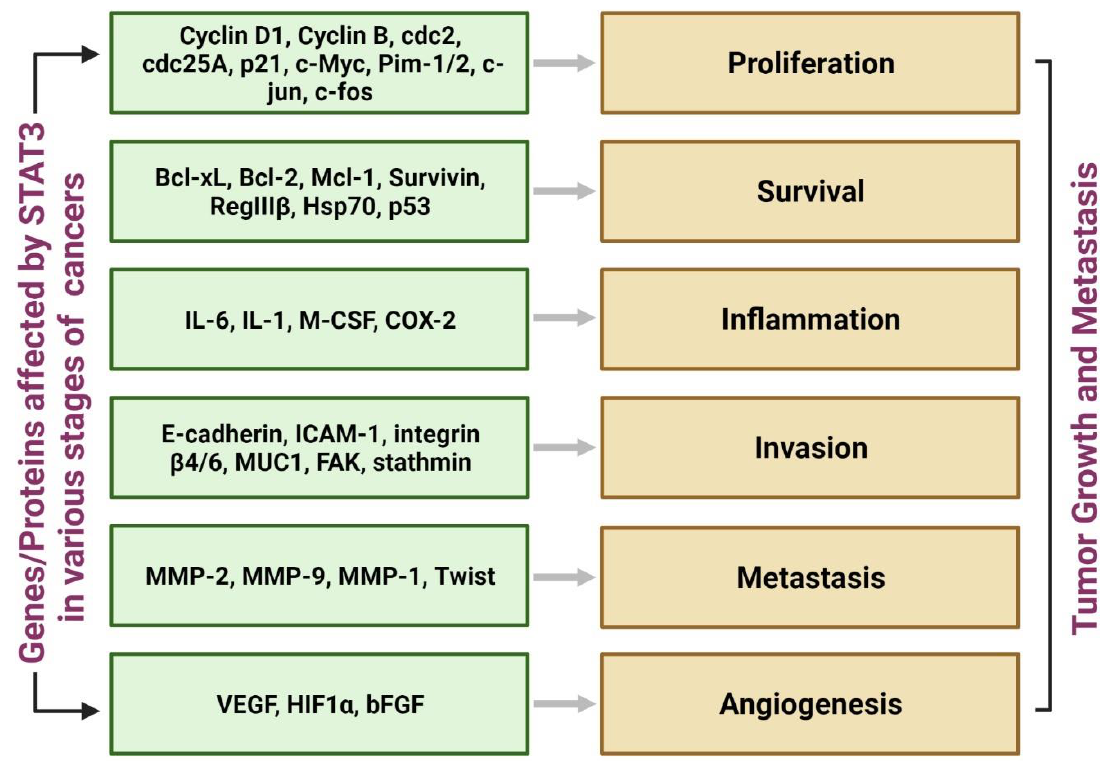
Figure 4. Complex Role of STAT3 in tumorigenesis and its progression.